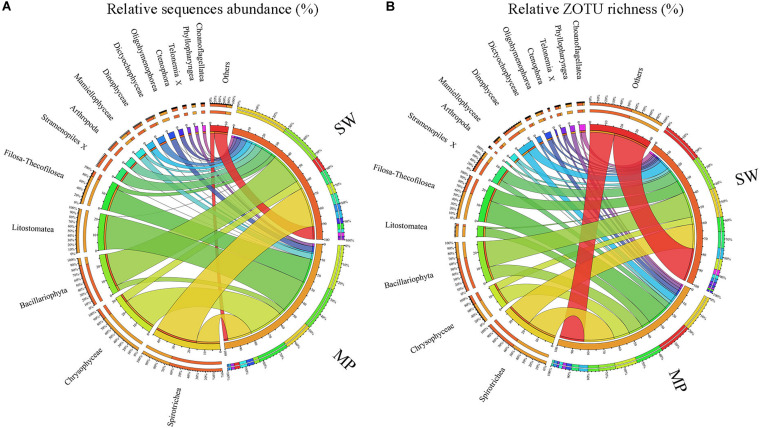
Overview of microbial eukaryotes in the pooled sea water (SW) and melt ponds (MPs). Relative sequence abuncance (A) and relative ZOTU richness (B), respectively.